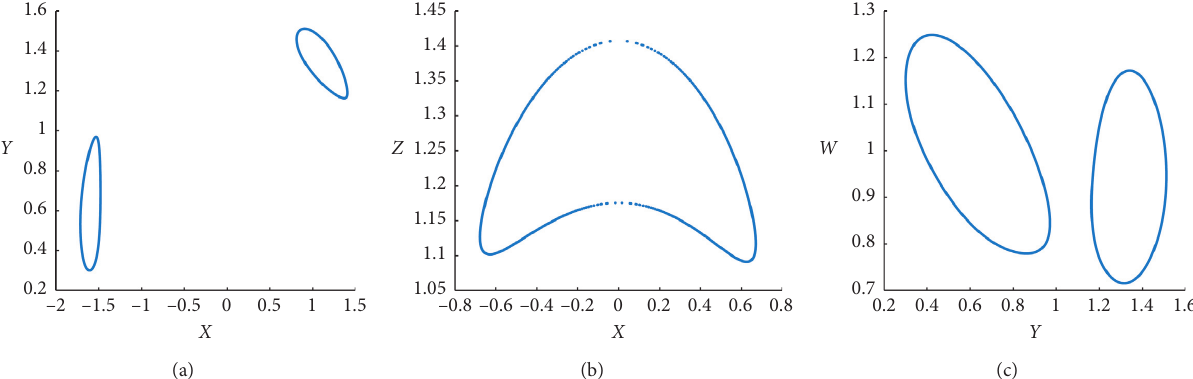
Figure 10: Phase portraits Poincare sections of Case 2 system on the different plane, with ( h, g,a,e ) � ( 0 . 5 , 20 , 6 , 5 . 5 ) and ,y ,z , w ) � ( 1 , 1 , 1 , 1 ) . (a) x - y plane. (b) x - z plane. (c) y-w plane. ( x 0 0 0 0